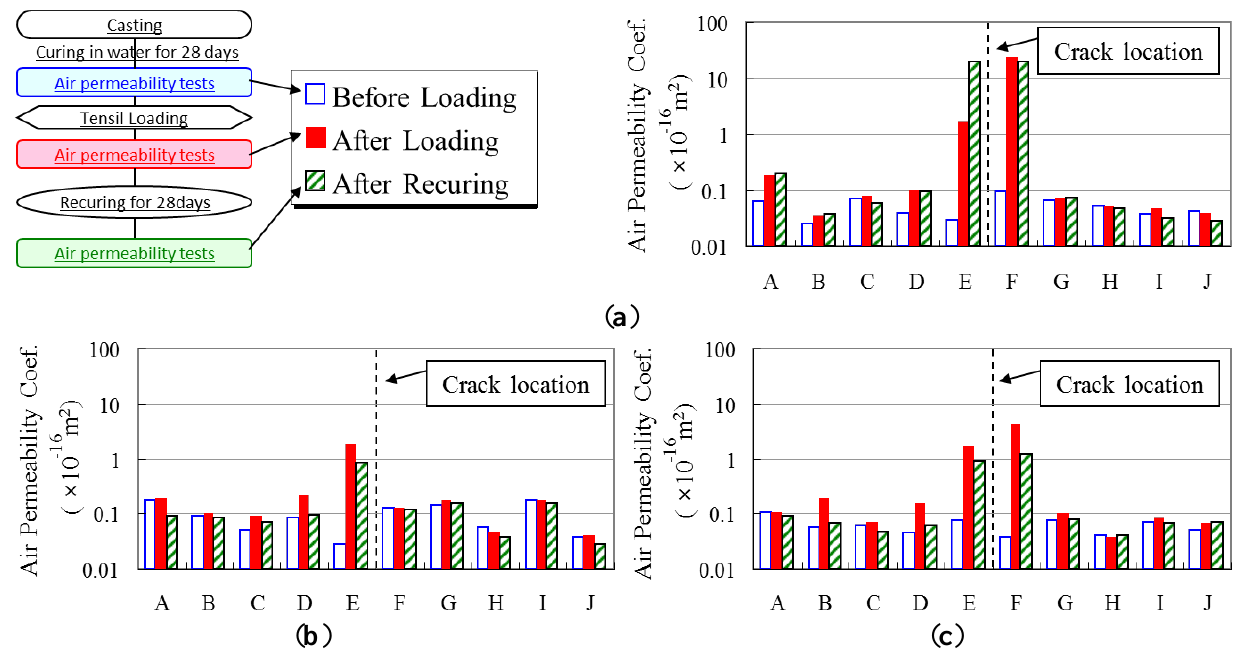
Figure 9. Normal concrete air permeability test results. ( a ) Recuring in air; ( b ) Recuring in water—Specimen No.1; ( c ) Recuring in water—Specimen No.2.